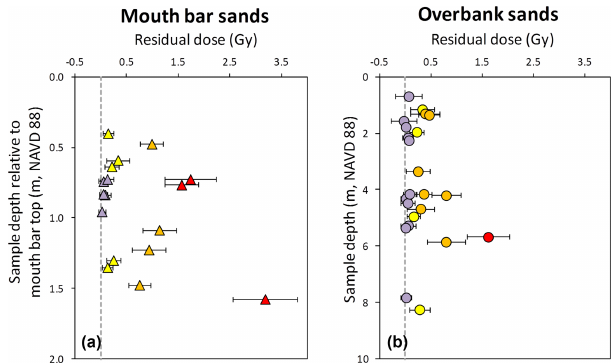
Figure 9. Bleaching of mouth bar (a) and overbank (b) sands with depth. Mouth bar sand depths are relative to the top of the mouth bar deposit, which formed at roughly sea level. Overbank sand depths are relative to mean sea level. Data points are color-coded by their minimum residual dose (see Fig.